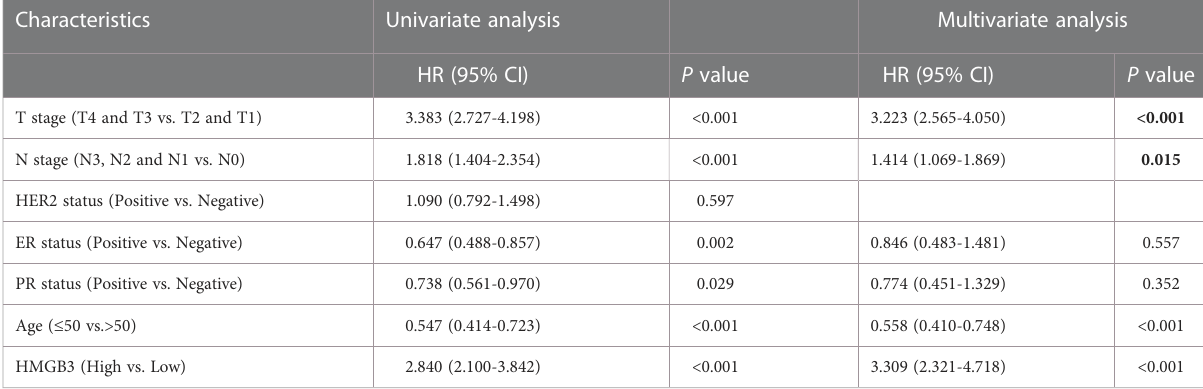
TABLE 4 Cox regression analysis of progression-free survival in patients with metastatic breast cancer.